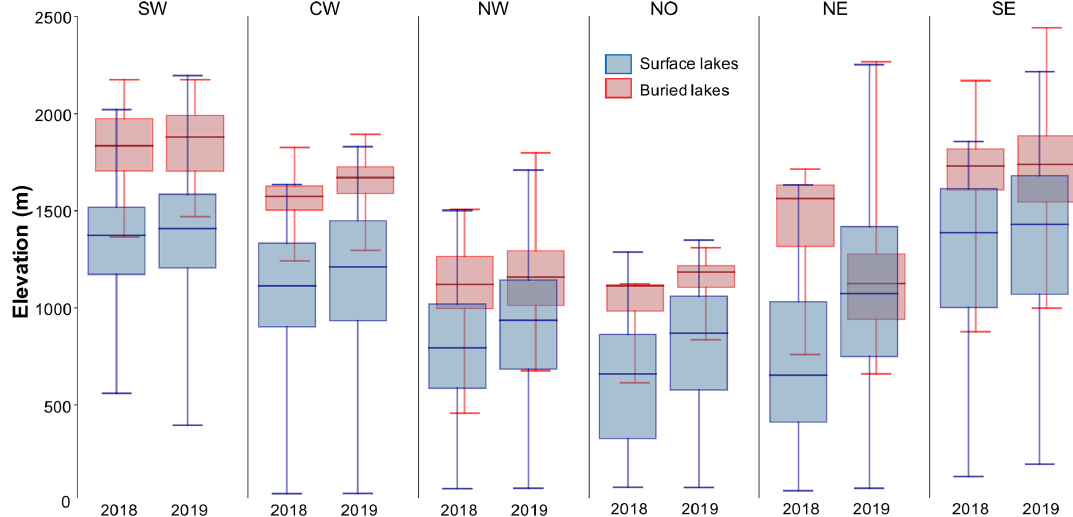
Figure B3. Box plots showing the distribution of detected buried (red) and surface (blue) lake elevations in each of the six GrIS subregions. Boxes represent the interquartile range of lake elevations, and whiskers represent the entire range of lake elevation in a given region/year.